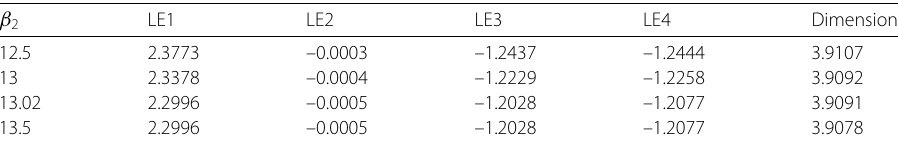
Table 2 LE for different fractional orders and simulation time of 300s β 2